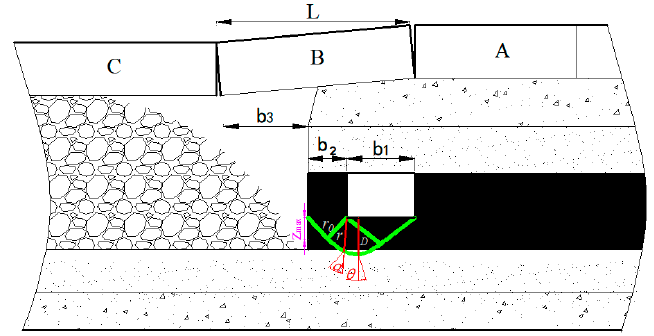
Figure 2. Bottom coal failure model in the gob-side entry.